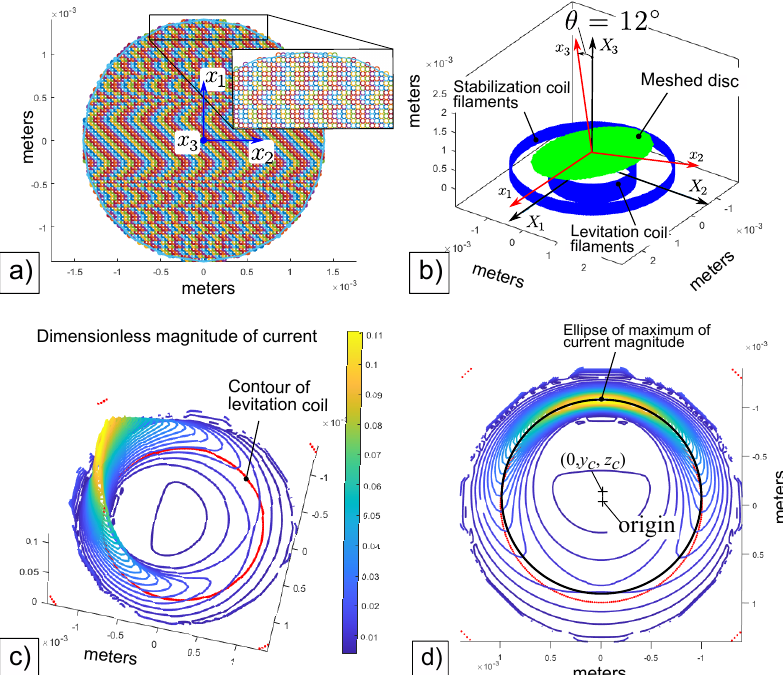
Figure 2. Simulation of eddy current: ( a ) the disc is meshed by circular elements n = 2496, { x k } ( k = 1,2,3) is the coordinate frame assigned to the center of disc; ( b ) 3D schematic diagram of the actuator; ( c ) 3D plot of the distribution of dimensionless magnitude of the eddy current along the surface of the disc; ( d ) 2D plot of the distribution of magnitudes of eddy